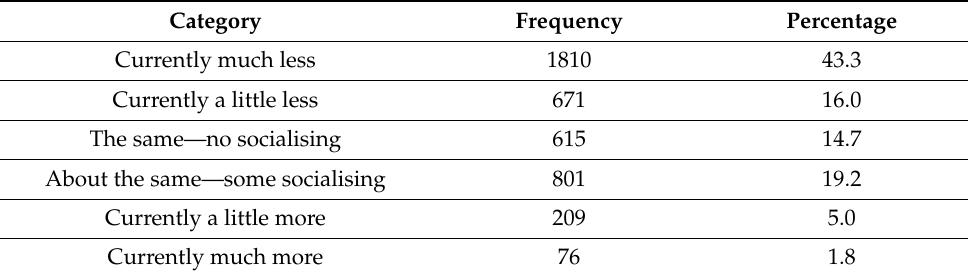
Table 6. Frequency with which dogs were reported to spend socialising with other dogs that they do not live with during lockdown, compared to early/mid-February 2020 ( n = 4182).